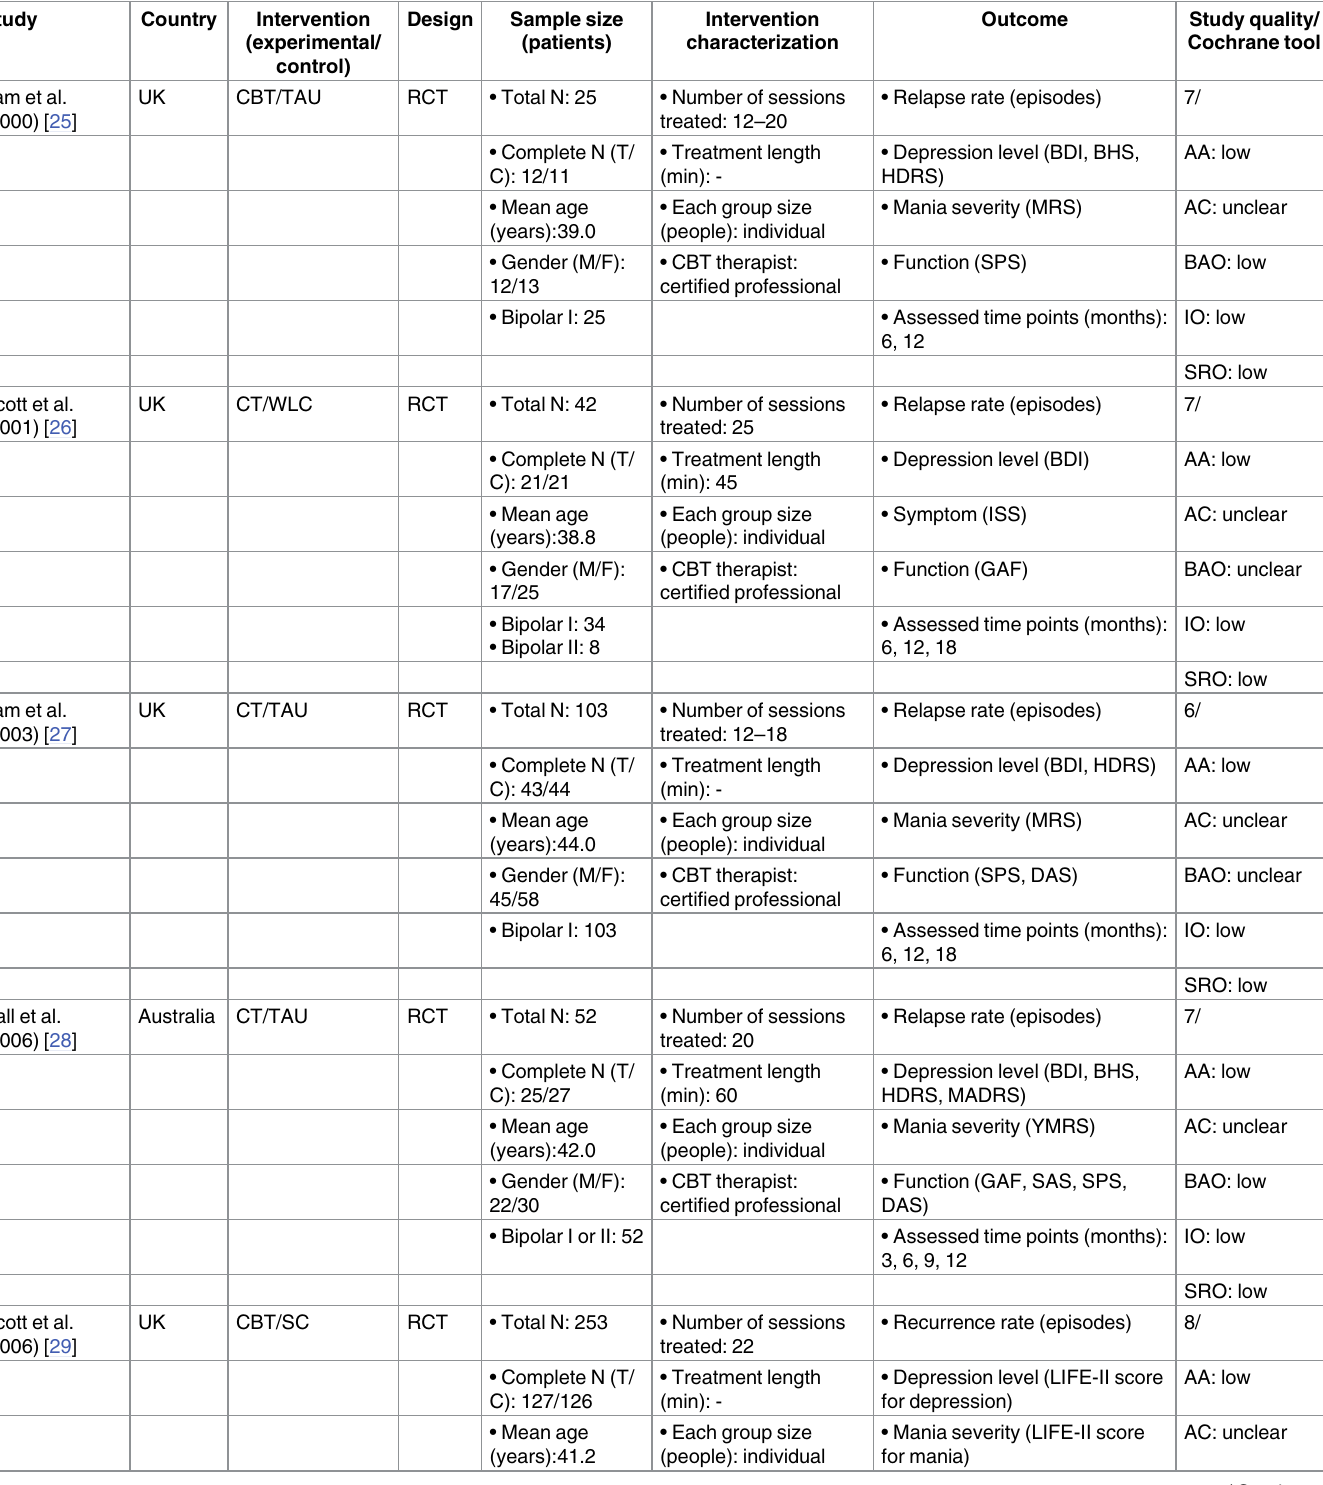
Table 1. Characteristics of cognitive-behavioral therapy for patients with bipolar disorder in the randomized controlled trials included in the meta- analysis (N =